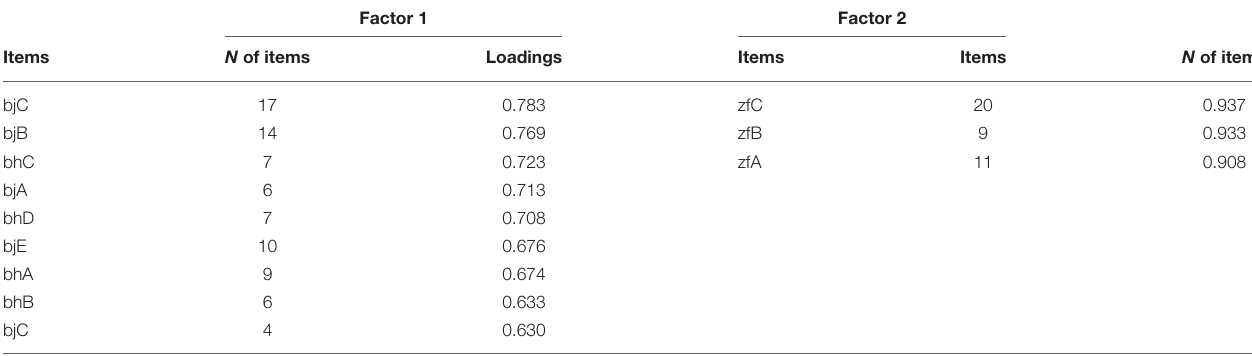
TABLE 5 | Exploratory factor analysis of each factor loading matrix for grades 5–6 scale (120 items). Factor 1 Factor 2